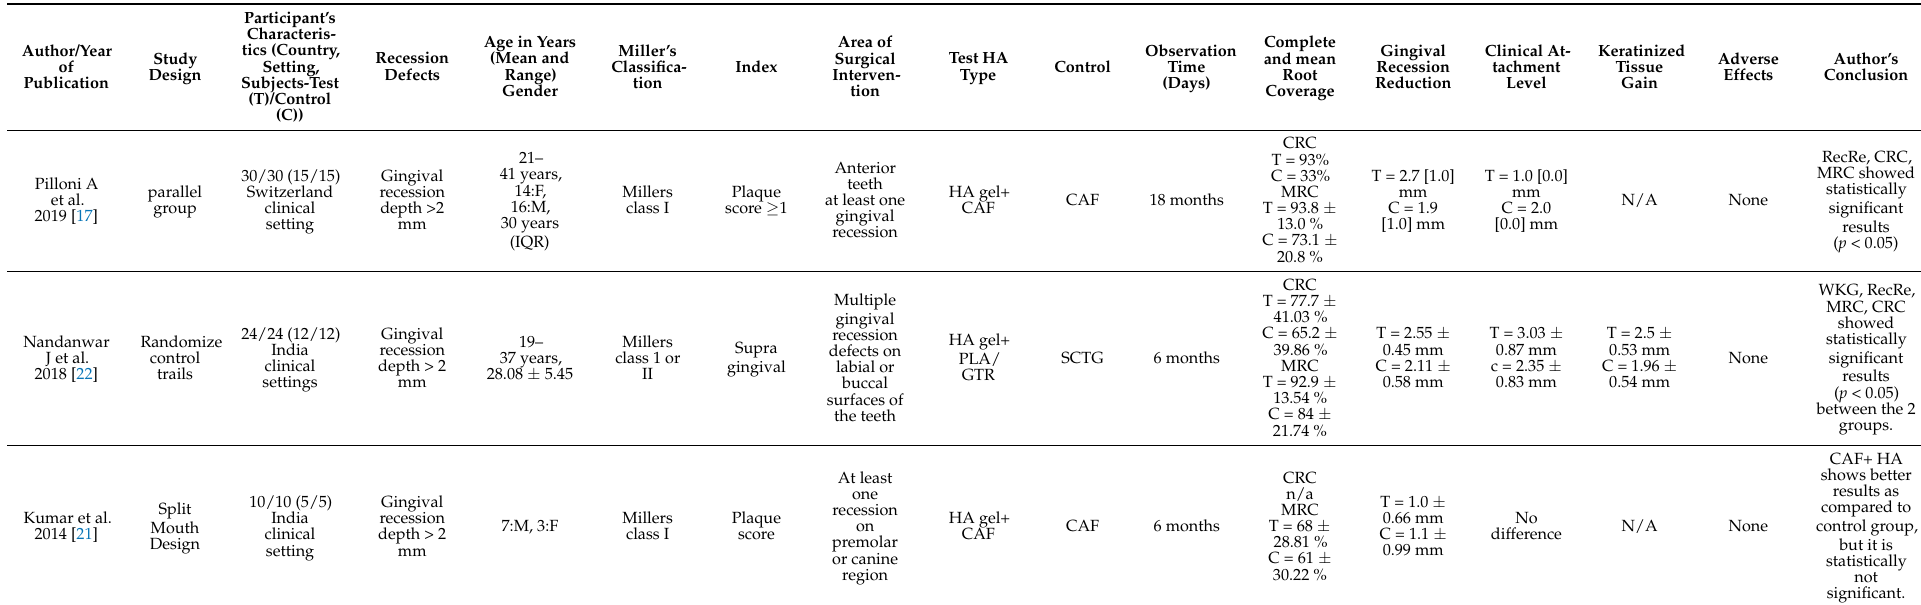
Table 3. Summary of Data